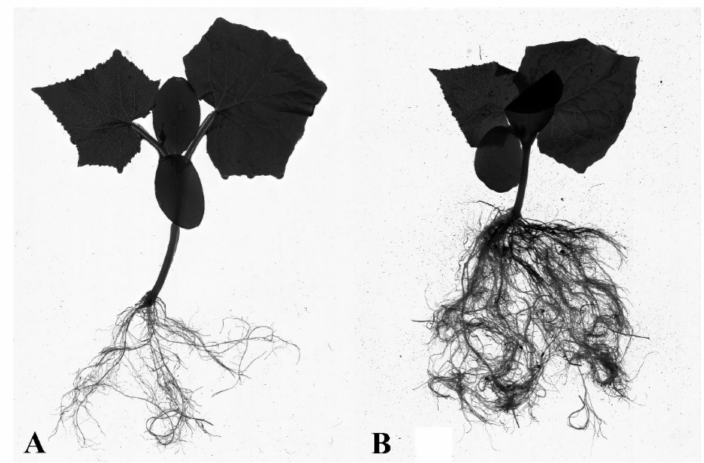
Figure 7. Overground part and root ball of cucumber in pots for S1 ( A ) and S5.3 ( B ). (S1—Uncoated seeds, S5.3—Seed coating containing a solution of 2% alginate with amino acids (112 mL/100 g), micronutrients (112 mL/100 g), and NPK). Table 10. Macro- and micronutrient content of plants and effect of coating on bioavailability (TF) of micronutrients (S1— Uncoated seeds, S5.1—Seed coating containing a solution of 2% alginate with amino acids (37.6 mL/100 g), micronutrients (37.5 mL/100 g), and NPK, S5.2—Seed coating containing a solution of 2% alginate with amino acids (75.1 mL/100 g), micronutrients (75.1 mL/100 g), and NPK, S5.3—Seed coating containing a solution of 2% alginate with amino acids (112 mL/100 g), micronutrients (112 mL/100 g), and NPK, S5.4—Seed coating containing a solution of 2% alginate